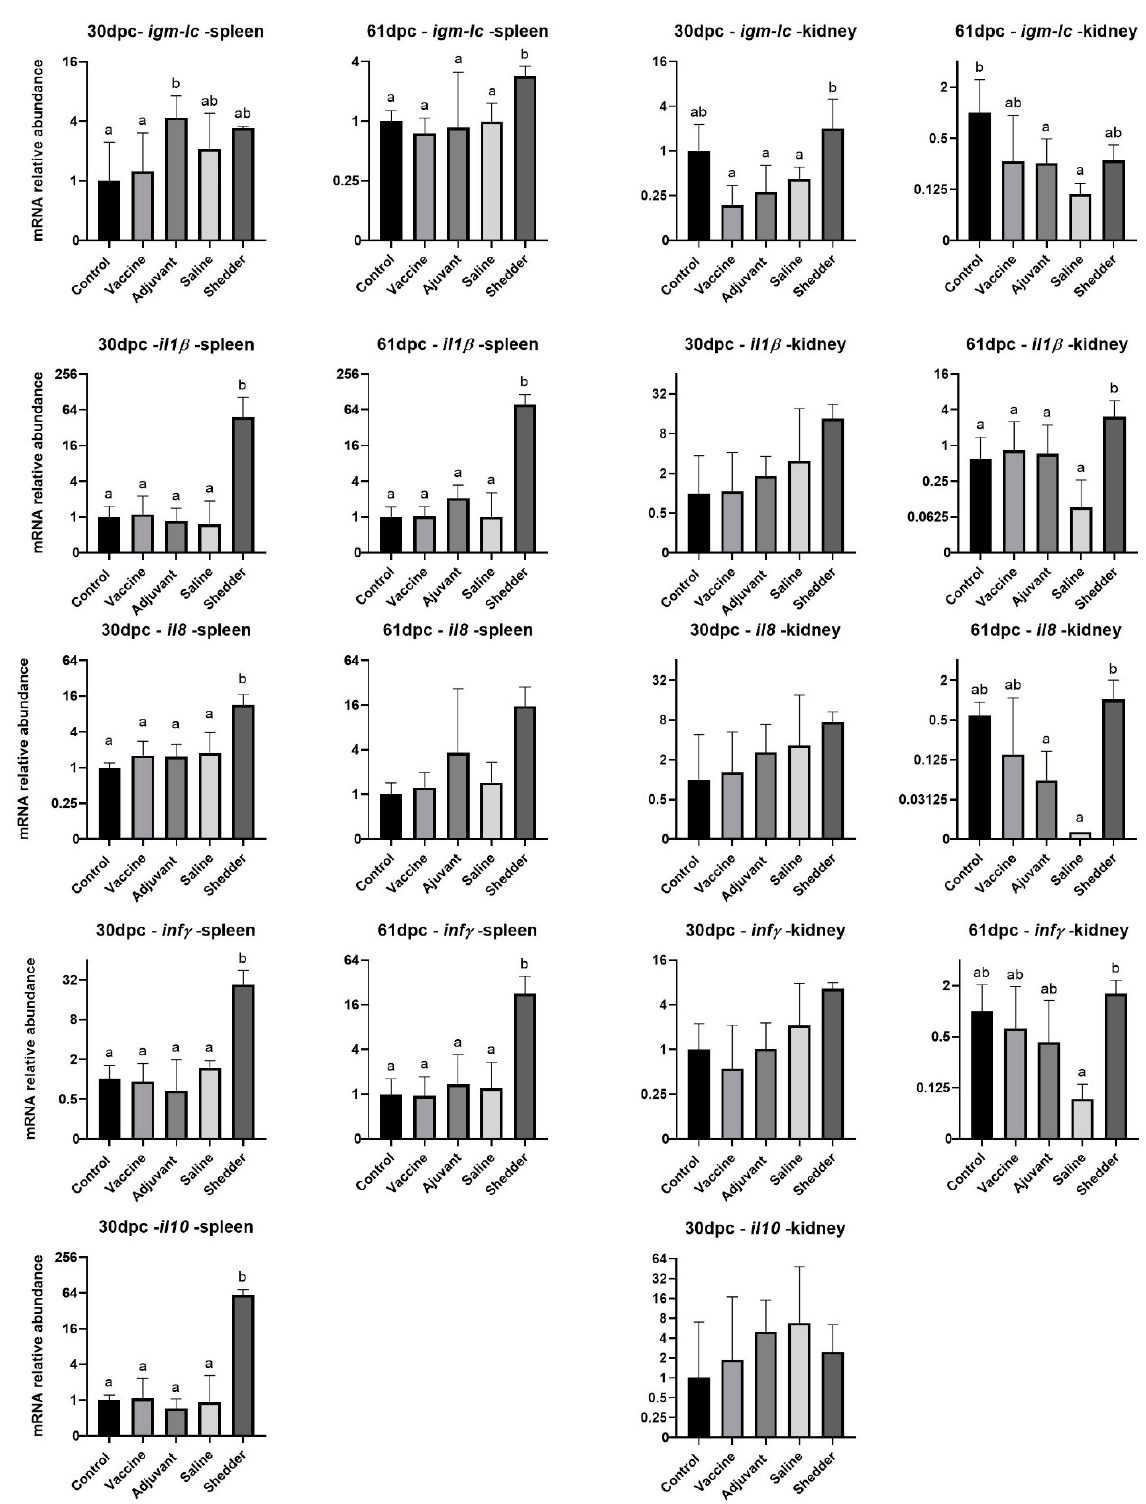
Figure 3. Immune gene expression levels in Atlantic cod immunized with Fnn MVs and challenged with Fnn . Sample analysis was performed by qPCR on the spleen and kidney at two time-points—30 and 61 dpc. The relative gene expression of different investigated genes displayed as log 2 of relative mRNA abundance. Results marked with different letters (a; b) indicate significant difference; groups that do not share letters are significantly different. The absence of letters indicates the lack of significant differences ( p < 0.05; one-way ANOVA with multiple comparisons using Tukey test; error bars indicate mean ± SEM). Note that scales on the Y -axis may